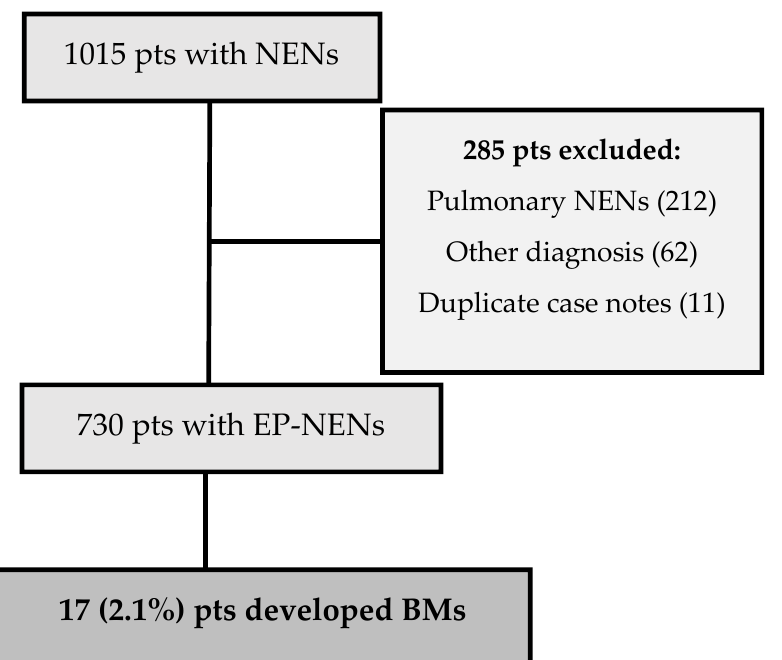
Figure 1. The CONSORT diagram of all new patient episodes with neuroendocrine neoplasm (NEN) diagnosis recorded and eligible patients remaining in the study following exclusions. Pts = patients. EP-NENs = extra pulmonary neuroendocrine neoplasms, BM=brain